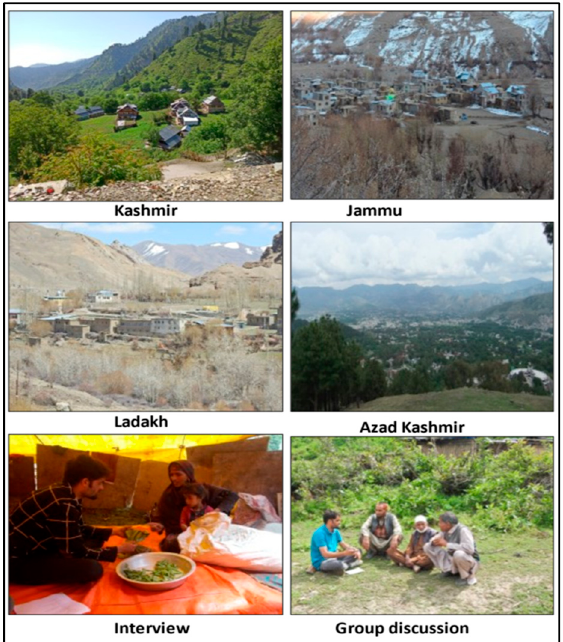
Figure 2. Representative survey sites in different bio-geographical regions for data collection. The photographs were taken by Shiekh Marifatul Haq and Musheer ul Hassan in Jammu, Kashmir and Ladakh, whereas in Azad Kashmir, the photographs were taken by Hammad Ahmad